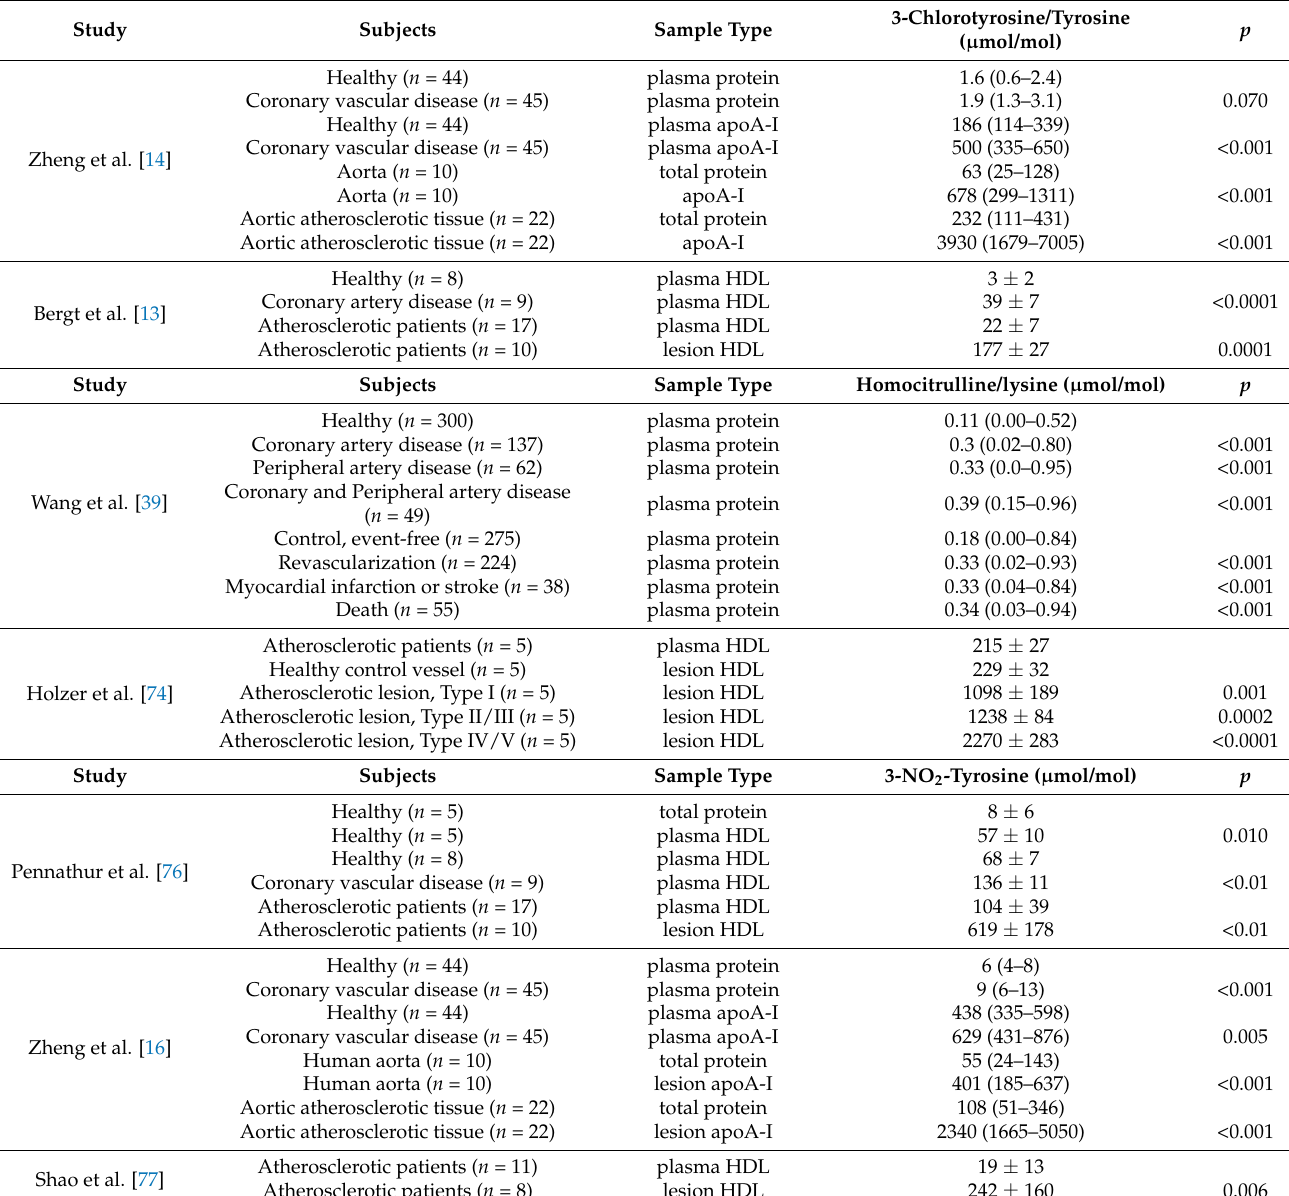
Table 1. Summary of studies evaluating MPO-mediated protein oxidation in